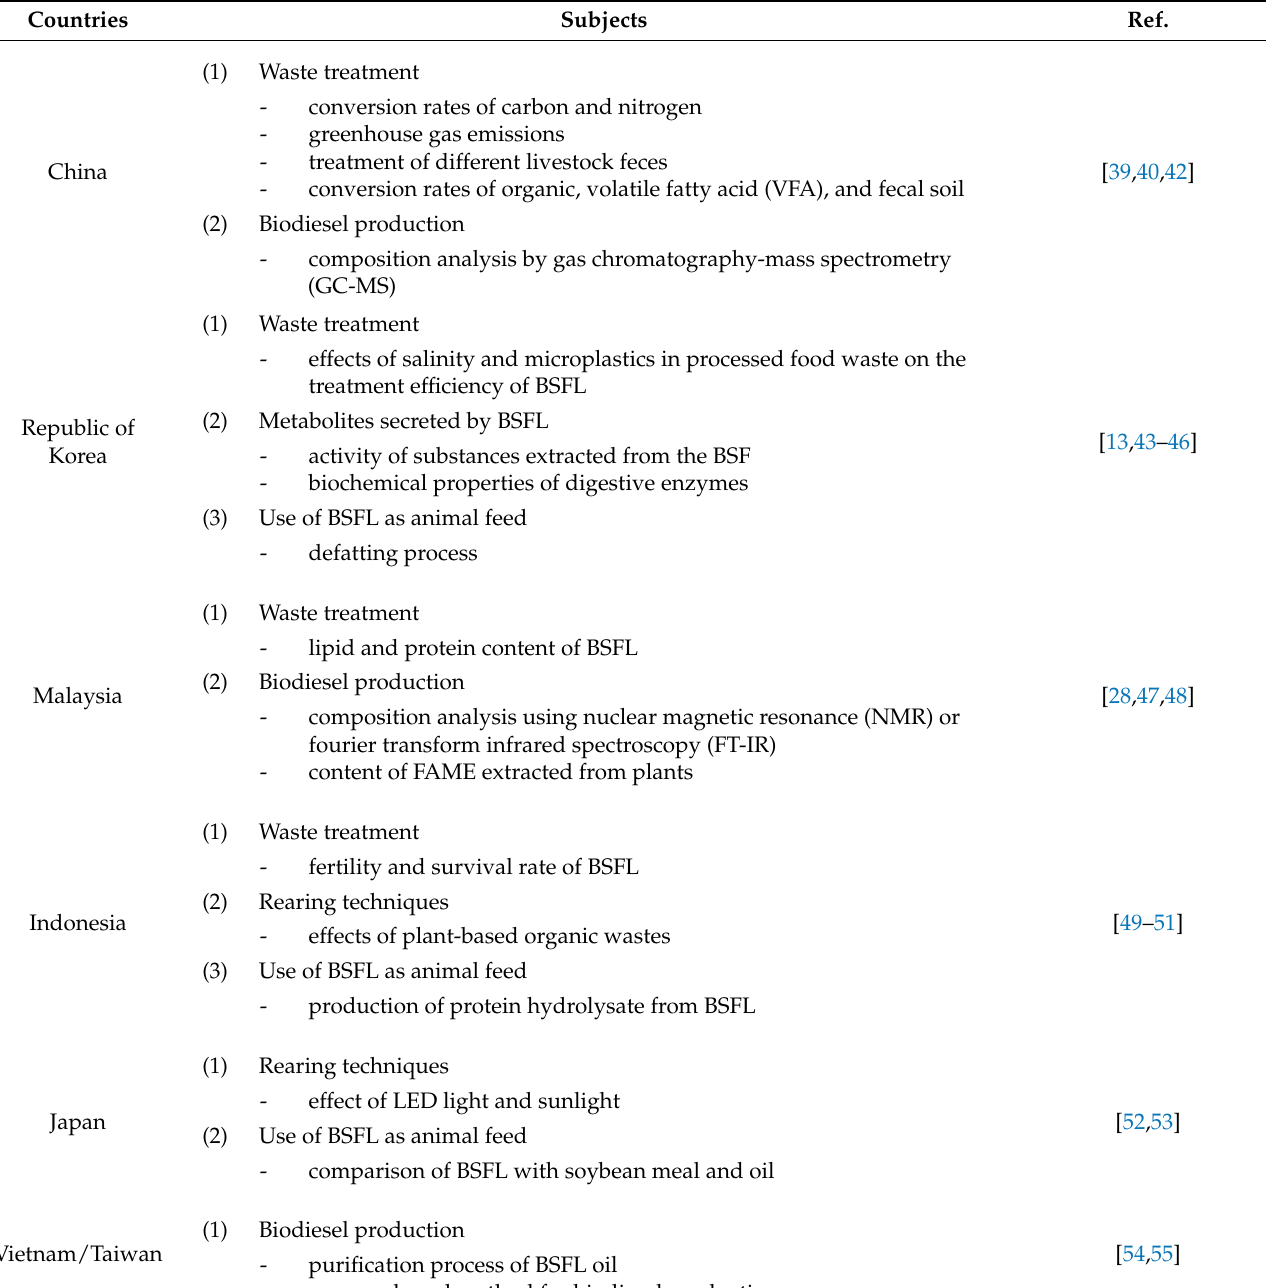
Table 1. Subjects of studies on BSFL in Asian countries. Subjects